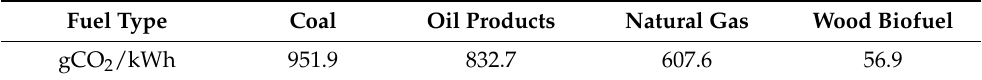
Table 1. The mean values of greenhouse gas emissions from varying fuels throughout the life cycle. Fuel Type